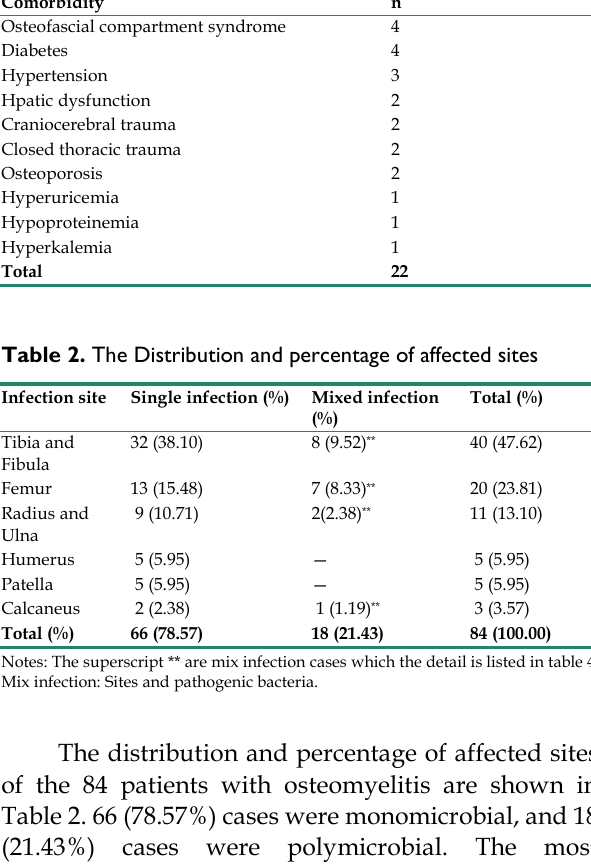
Table 1. Medical comorbidities in patients with osteomyelitis Comorbidity